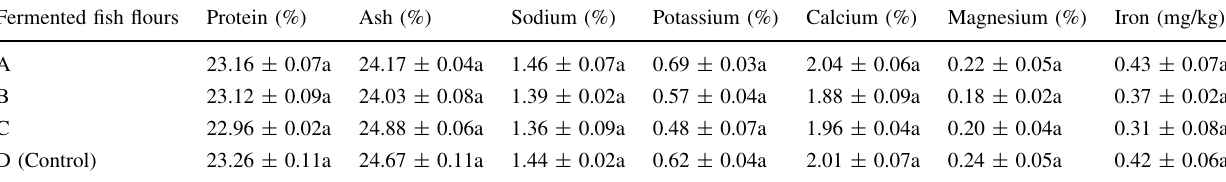
Table 3 Nutritional characteristics of different types of fermented fish flours investigated Fermented fish flours